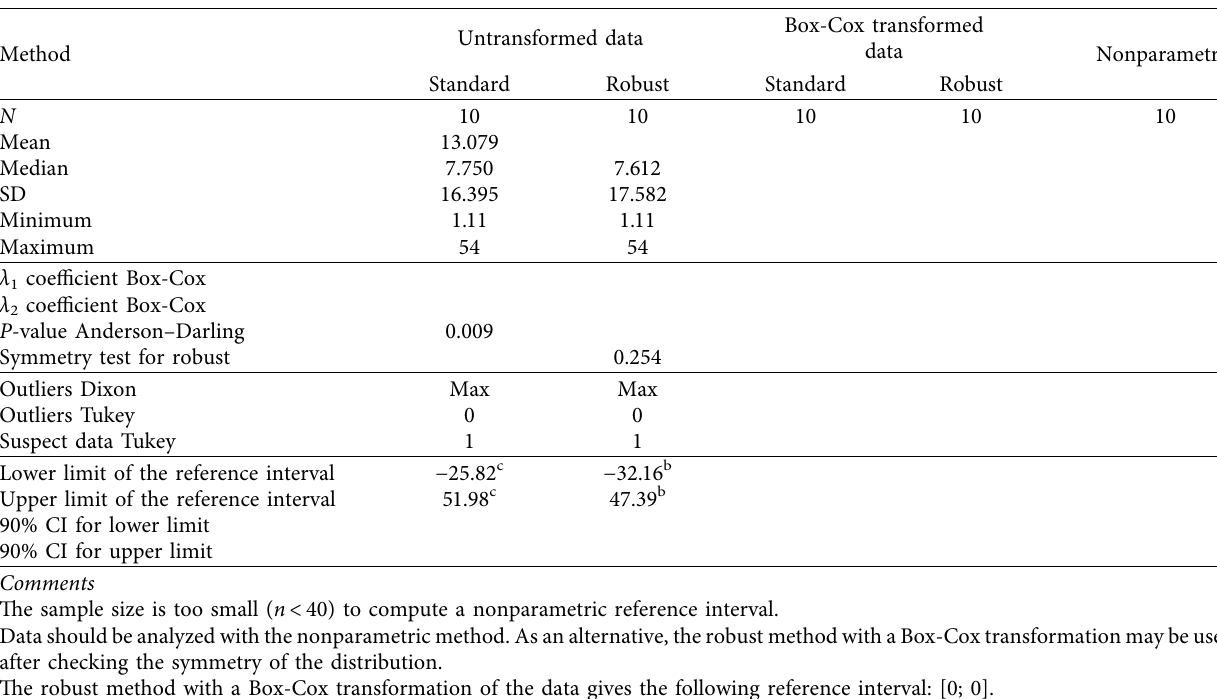
Table 3: Computations made with a series of 10 EBCR mean amplitude values ( μ